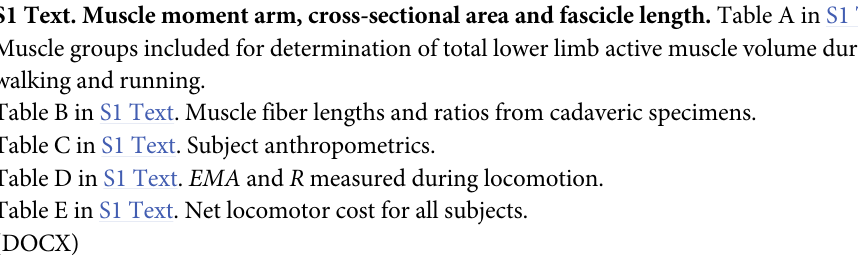
Table B in S1 Text. Muscle fiber lengths and ratios from cadaveric specimens. Table C in S1 Text. Subject anthropometrics. Table D in S1 Text. EMA and R measured during locomotion. Table E in S1 Text. Net locomotor cost for all